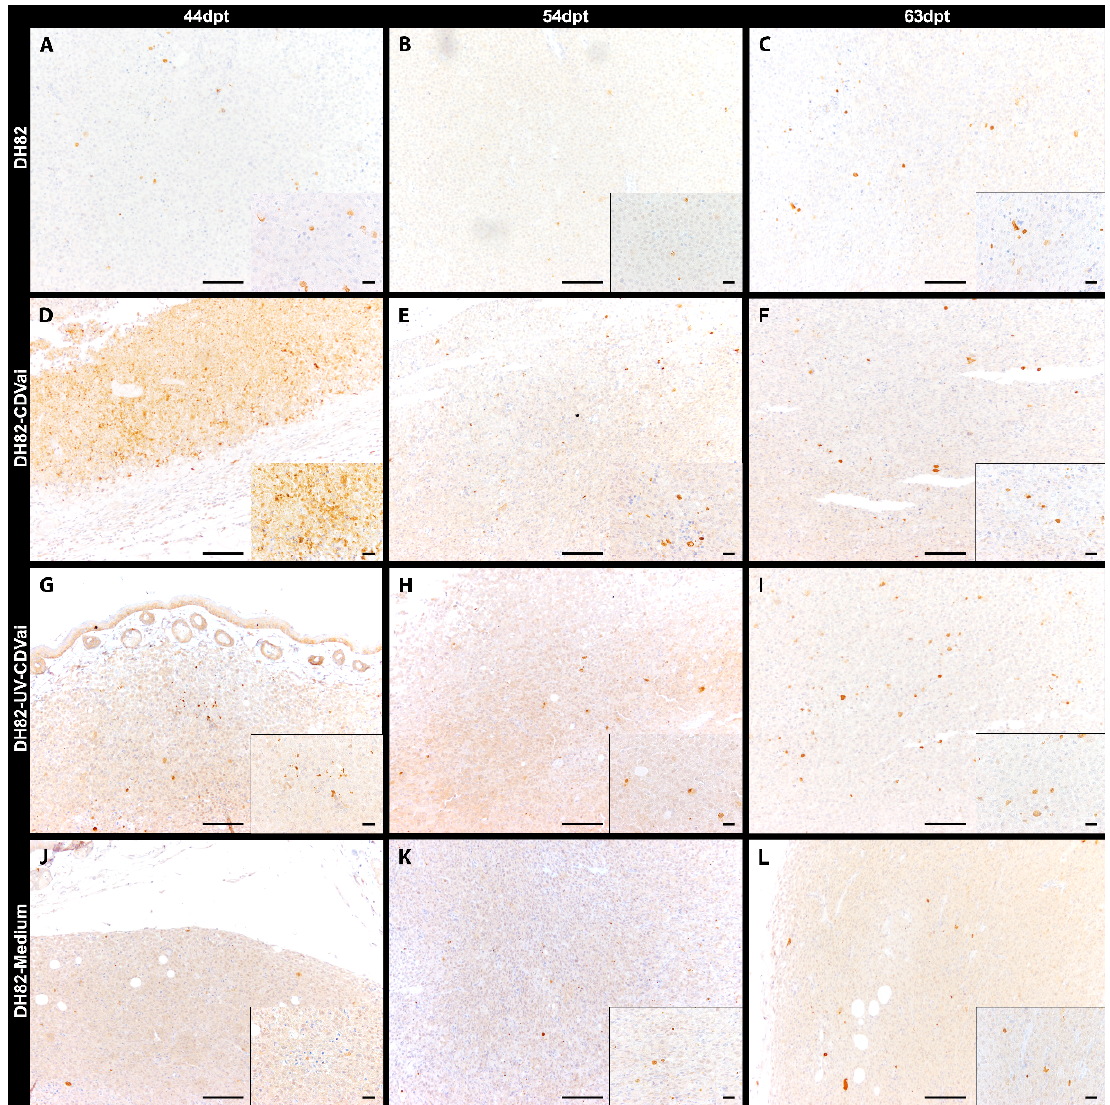
Figure 3. Cleaved caspase-3 immunolabeling in murine subcutaneous DH82 cell xenografts ( A – L ). ( A – C ) display non- infected (DH82), ( D – F ) intratumorally CDV-infected (DH82-CDVai), ( G – I ) intratumorally UV-inactivated CDV-injected (DH82-UV-CDVai) and ( J – L ) intratumorally medium-injected (DH82-medium) neoplasms at ( A , D , G , J ) 44 days post-transplantation (dpt), ( B , E , H , K ) 54 dpt, and ( C , F , I , L ) 63 dpt. Scale bar = 100 μ m and scale bar—insert = 20 μ m.